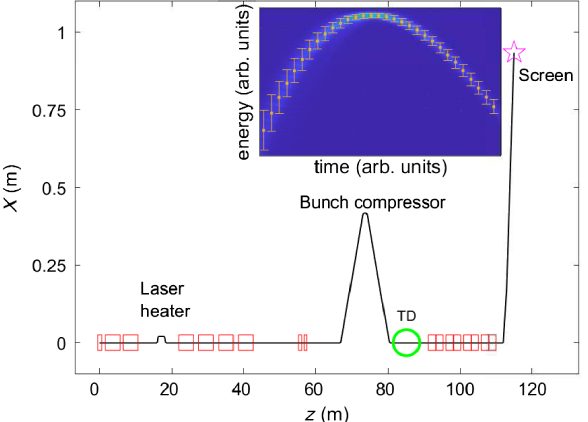
FIG. 1. Sketch of the SwissFEL injector and example of an image of a streaked beam. In the sketch, z corresponds to the longitudinal direction along the accelerator, X is the horizontal position, the red boxes indicate rf accelerating structures, the green circle corresponds to the TD, and the magenta star indicates the position of the profile monitor. In the image, the white points and error bars indicate the slice centroids and slice beam sizes,